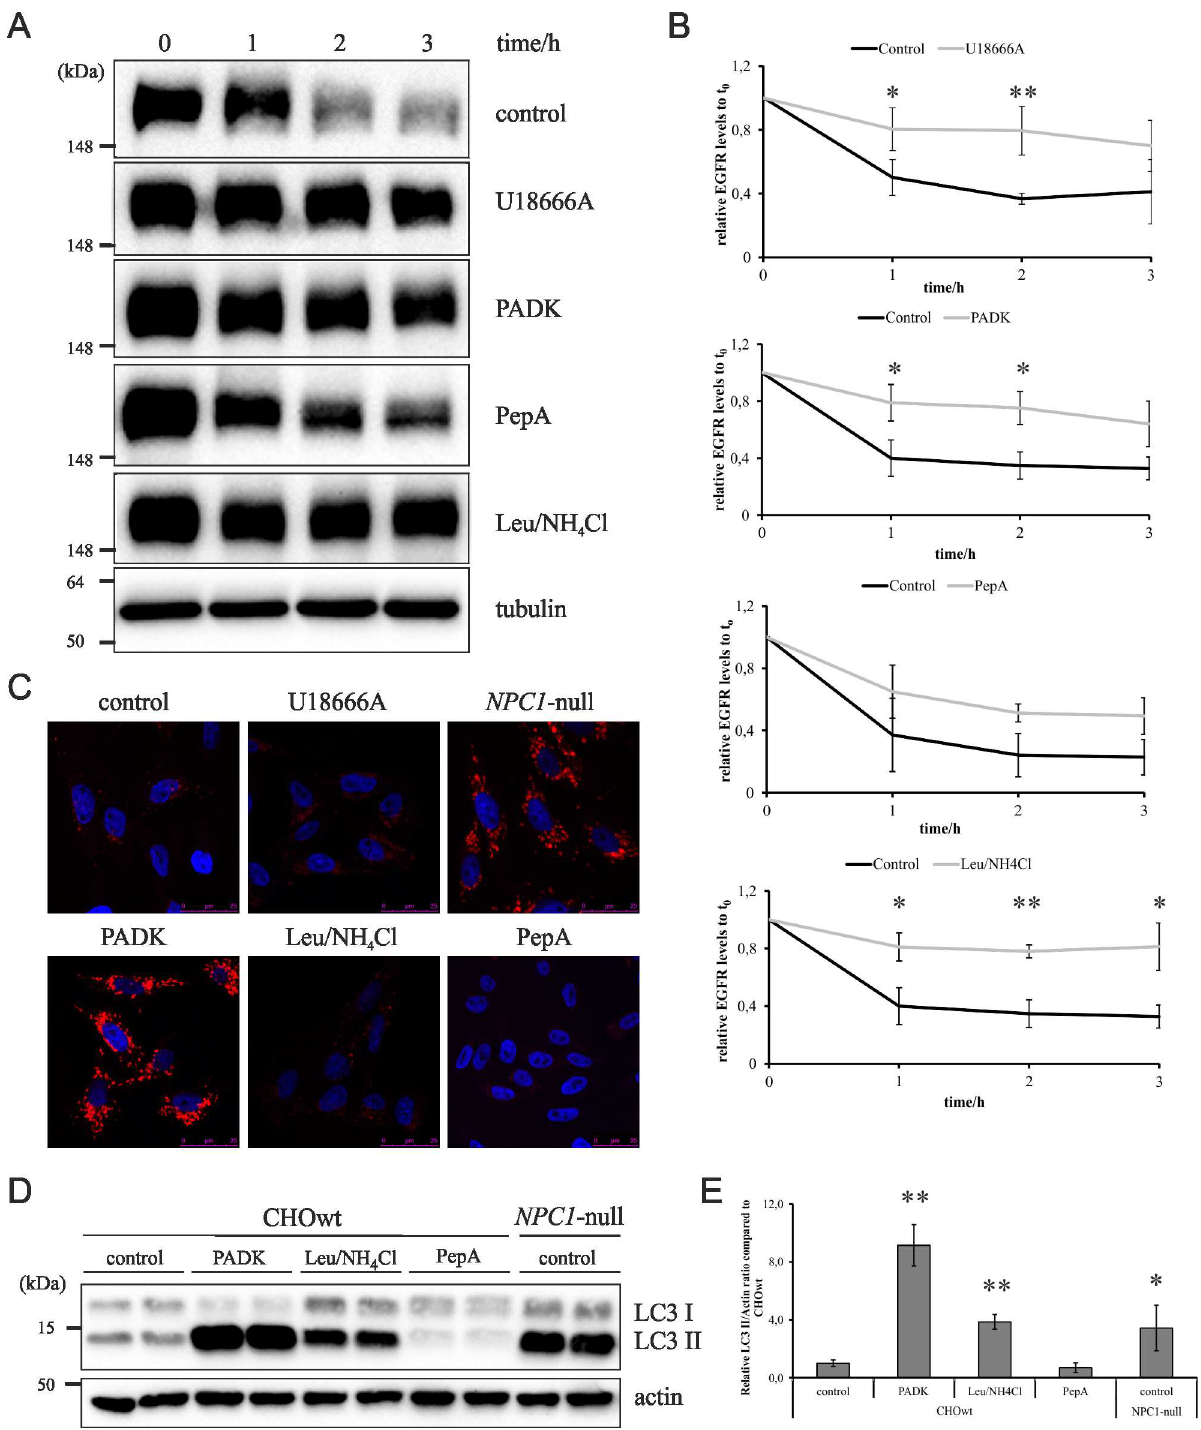
Fig 1. Inhibition of cathepsin B/L and not cathepsin D causes lysosomal dysfunction. (A) EGFR degradationassay. Western blot analysisof EGFR in SH-SY5Y cells treated with different inhibitorsat different time points. α -Tubulinwas used as a loadingcontrol. (B) Quantification of Western blot results of the 3 independentexperiments was performed by ImageJ. Student t-test was used for statistical analysis. Error bars present the mean ± standard deviation( * p < 0.05, ** p < 0.01). (C) Confocalmicroscopyof CHOwt cells treated with different inhibitors and CHO NPC1 -nullcells. LysoTracker (red) and Hoechst (blue). (D) Western blot of CHOwt cells treated with different inhibitorsand CHO NPC1 -nullcells using LC3 antibody. β -Actin was used as a loadingcontrol. (E) Quantification of Western blot results of